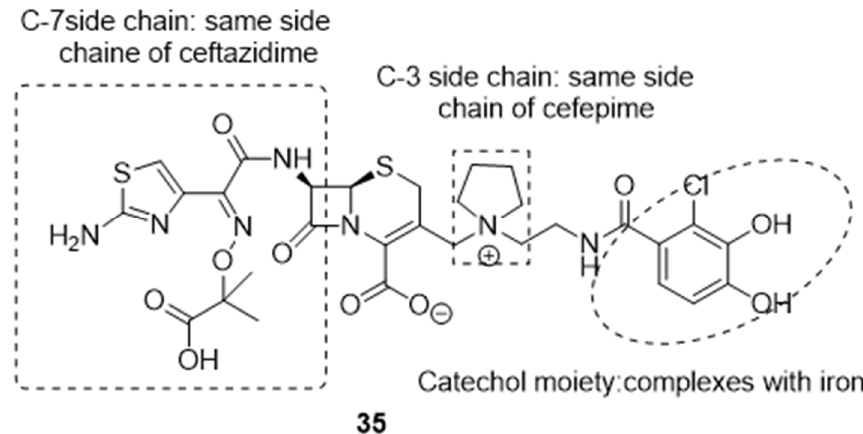
Figure 12 . Structure of cefiderocol 35 . Figure 12. Structure of cefiderocol 35 .